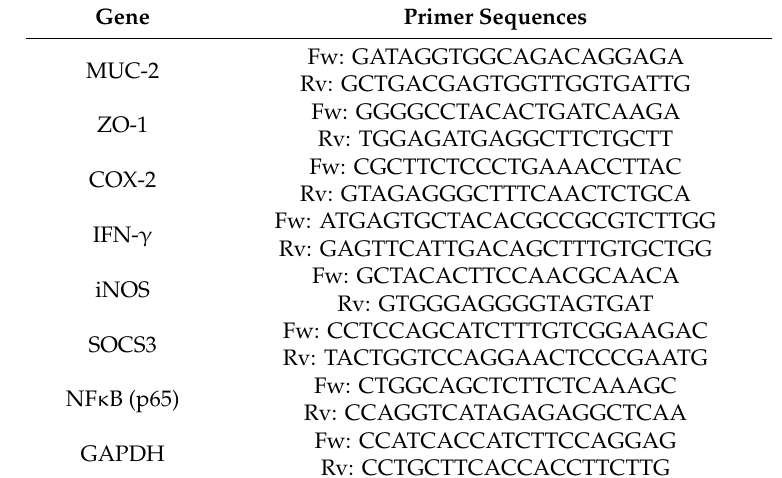
Table 3. List of assessed genes and primer sequences evaluated by RT-qPCR in colon samples from TNBS-induced ulcerative colitis